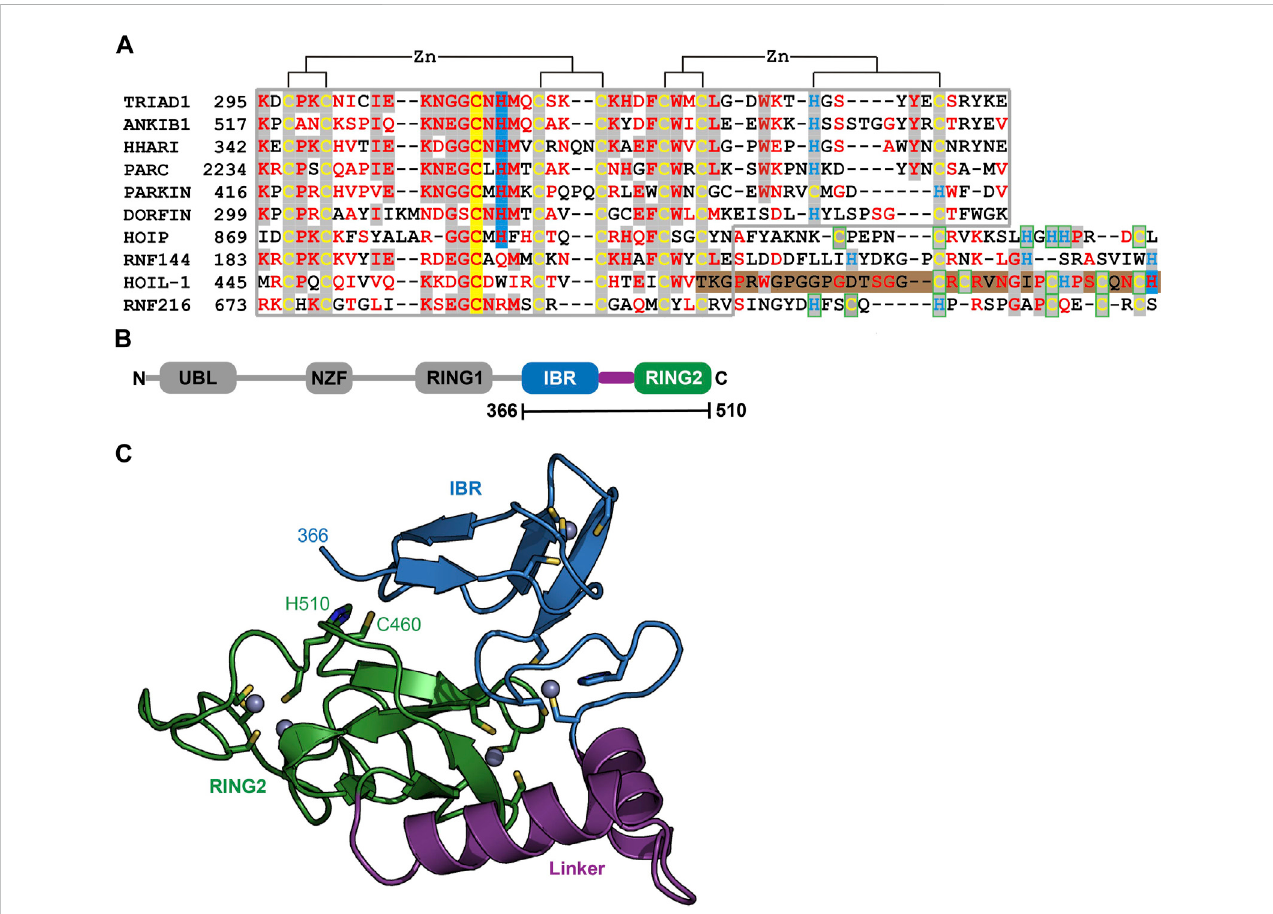
FIGURE 2 Structural characterizationofHOIL-1showsauniquedeviationoftheRING2domain. (A) TheRING2domains ofhumanRBRdomainshave beenaligned according to conserved Zn 2+ coordinating residues. Catalytic cysteine and histidine residuesare depicted on a yellow and blue background, respectively. The C-terminal binuclear Zn-cluster of HOIL-1 is represented on a brown background. (B) Domain architecture of HOIL-1 illustrates the boundaries of the crystallized construct. (Domain acronyms: UBL, ubiquitin like domain; NZF, Npl4 zinc fi nger; RING1/2, really interesting new gene domain; IBR = in between RINGdomain). (C) Structuralmodel ofresidues366 – 510 of HOIL-1 as ribbonmodels with Zn 2+ ions as grey spheres.Zn 2+ coordinating residues, the catalytic cysteine and histidine are shown as a stick